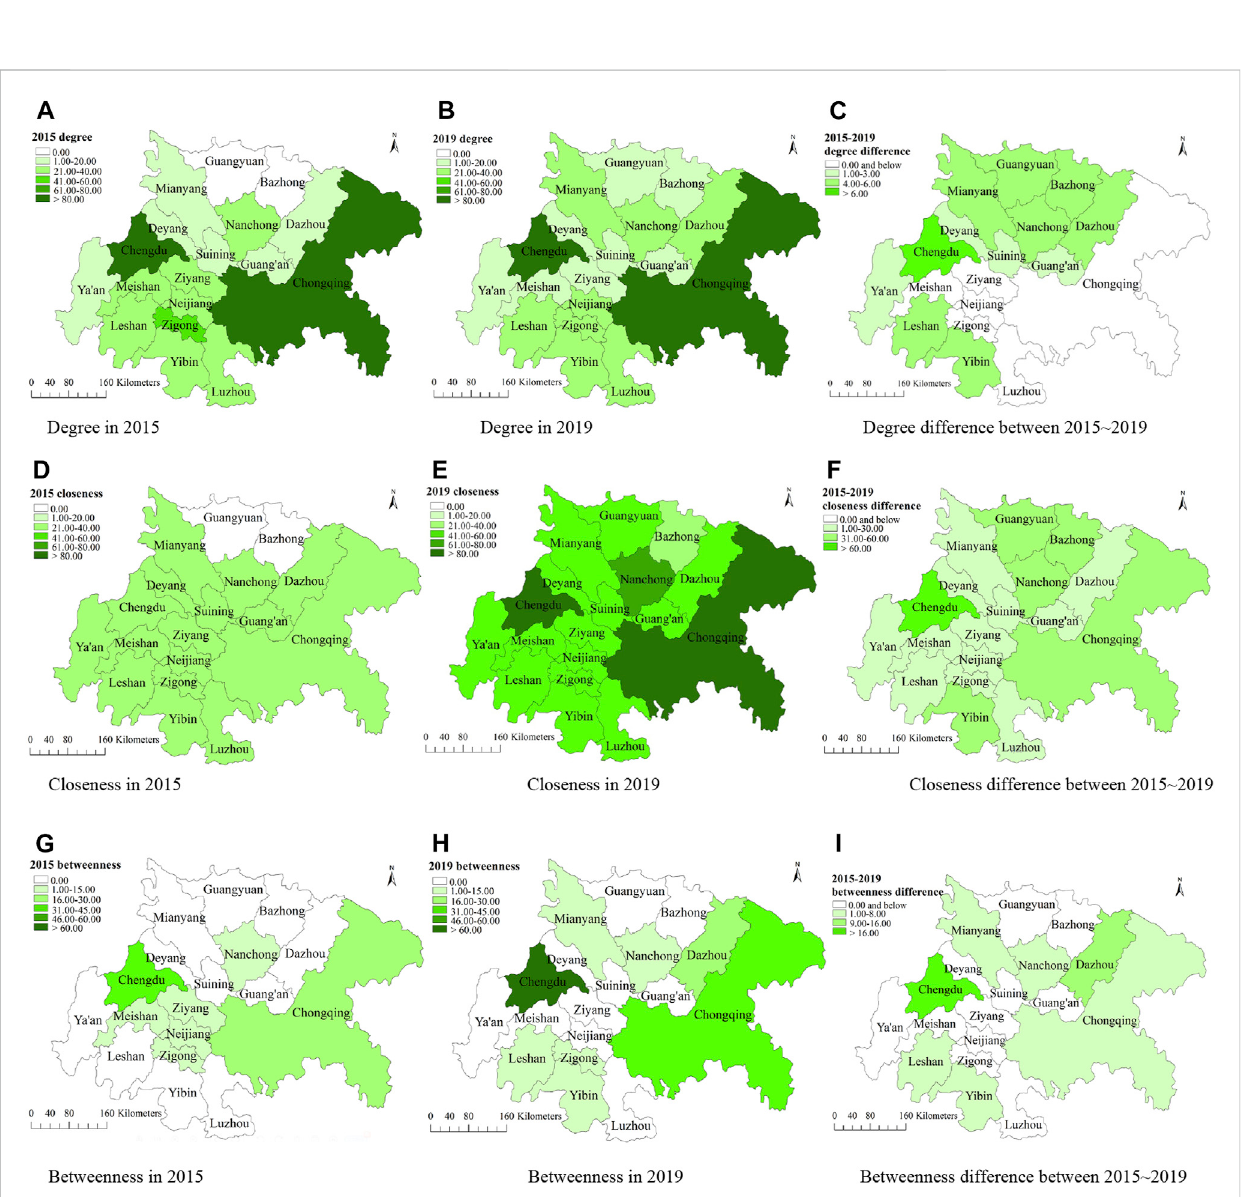
FIGURE 8 Spatiotemporal evolution of degree, closeness and betweenness in PM 2.5 association in SCB (2015, 2019). (A) Degree in 2015 (B) Degree in 2019 (C) Degreedifferencebetween2015and2019 (D) Closenessin2015 (E) Closenessin2019 (F) Closenessdifferencebetween2015and2019 (G) Betweenness in 2015 (H) Betweenness in 2019 (I) Betweenness difference between 2015 and